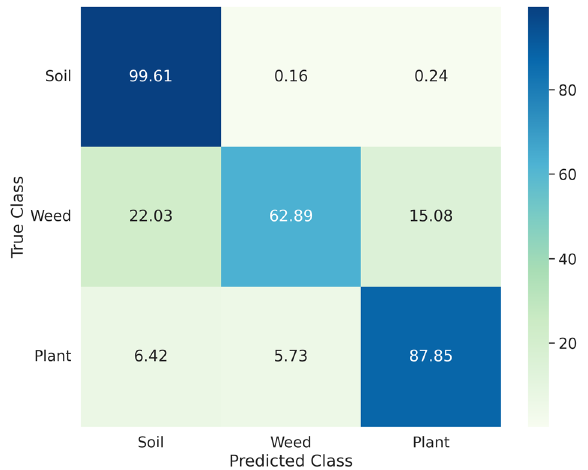
Figure 5 . Normalized confusion matrix of the U-Net model.